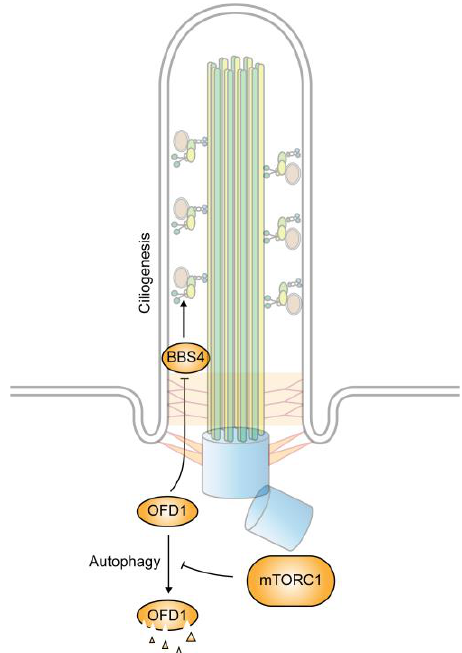
Figure 4. Regulation of ciliogenesis by autophagy. Increased autophagy under starvation condition promotes ciliogenesis by the selective degradation of oral – facial – digital syndrome type 1 (OFD1), an inhibitor of BBSome formation. The autophagy-mediated degradation is negatively regulated by mTORC1.